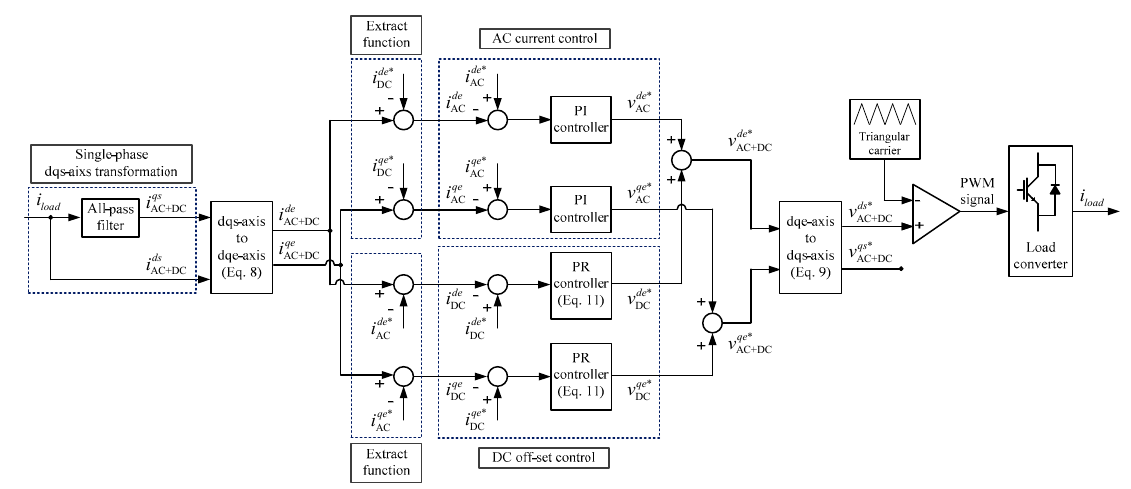
Figure 8. Block diagram of the proposed current control.